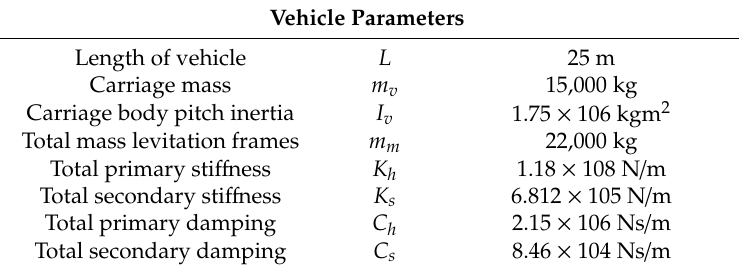
Table 1. Quantities characterizing the Hyperloop vehicle.